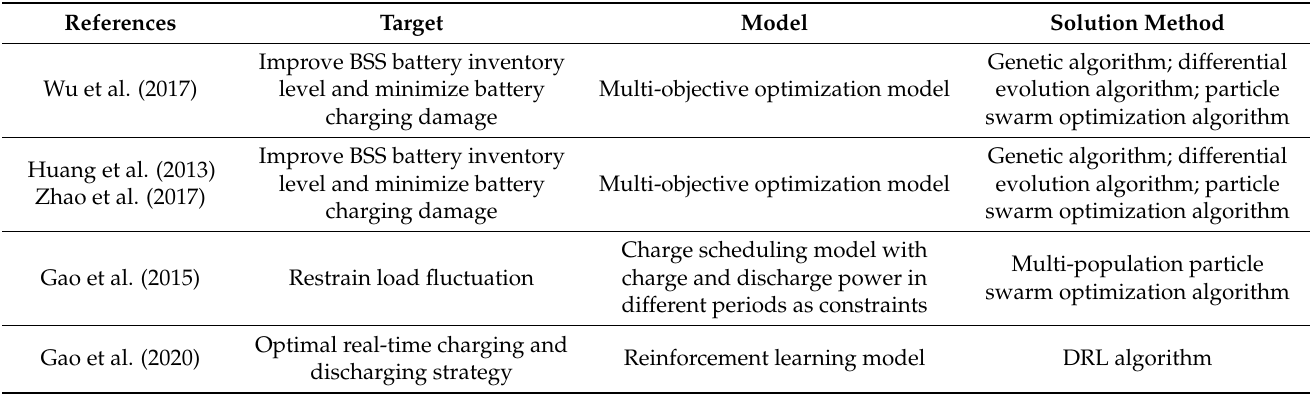
Table 4. Battery charging strategy of